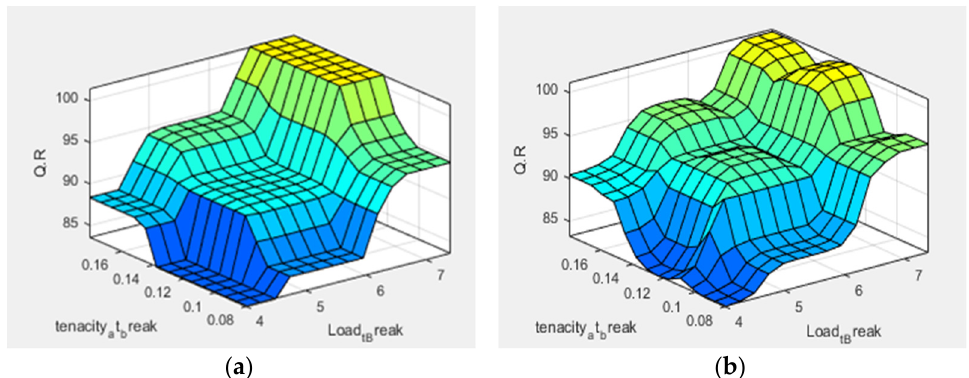
Figure 8. Surface view of load at break (X-axis) and tenacity at break (Y-axis) effect of jute yarn quality (Z-axis); ( a ) for triangular membership function and ( b ) gaussian membership function.